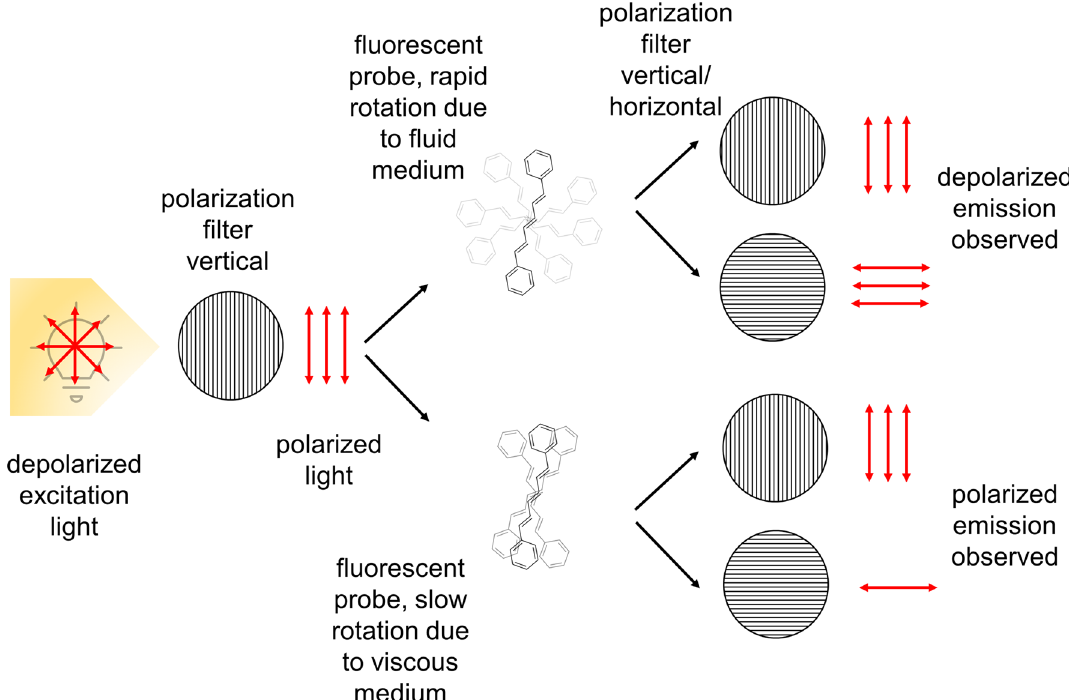
Fig. 1 Principle of fluorescence anisotropy assay. The fluorescent probe DPH is excited by light which is polarized by a polarization filter in vertical position. When the probe is in a fluid surrounding, e.g. a membrane, it rotates and the emitted light is depolarized. When the membrane gets more viscous the rotation is attenuated and the emitted light is more polarized. The fluorescence intensity is measured by applying parallel and perpendicular polarization filters to the excitation light